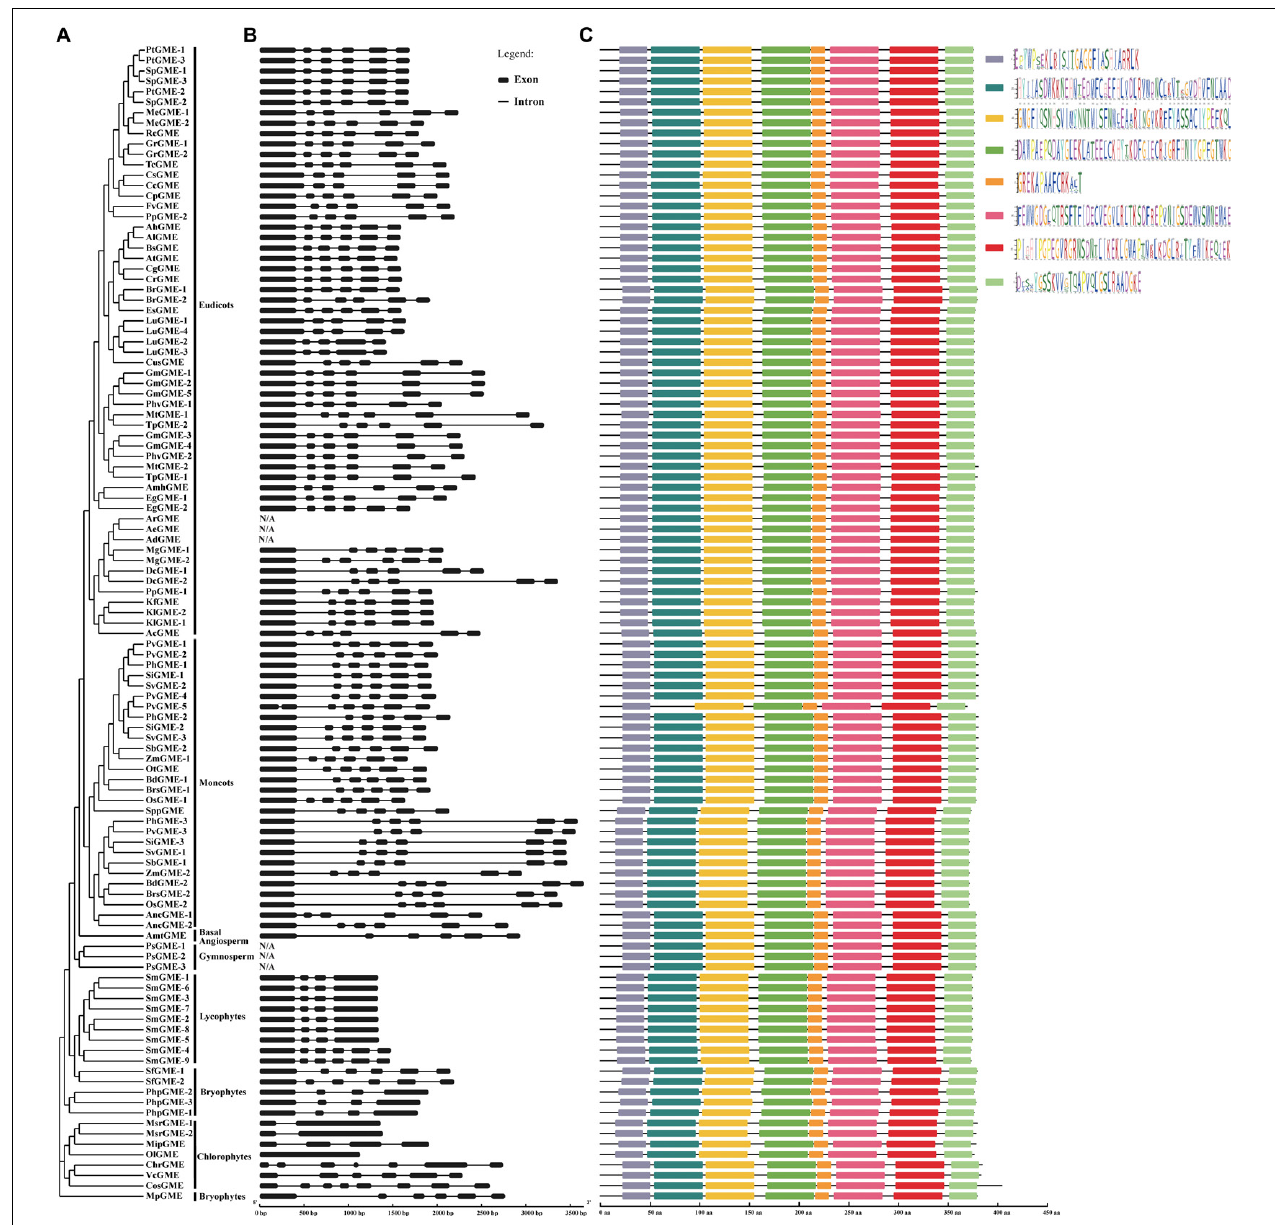
FIGURE 3 | GME gene structure and conserved motifs in Viridiplantae. (A) Phylogenetic tree of plant GME genes. (B) Exon-intron structures of plant GME genes. (C) Schematic diagram of conserved motifs of GME proteins. Different motifs were shown by different-colored boxes.